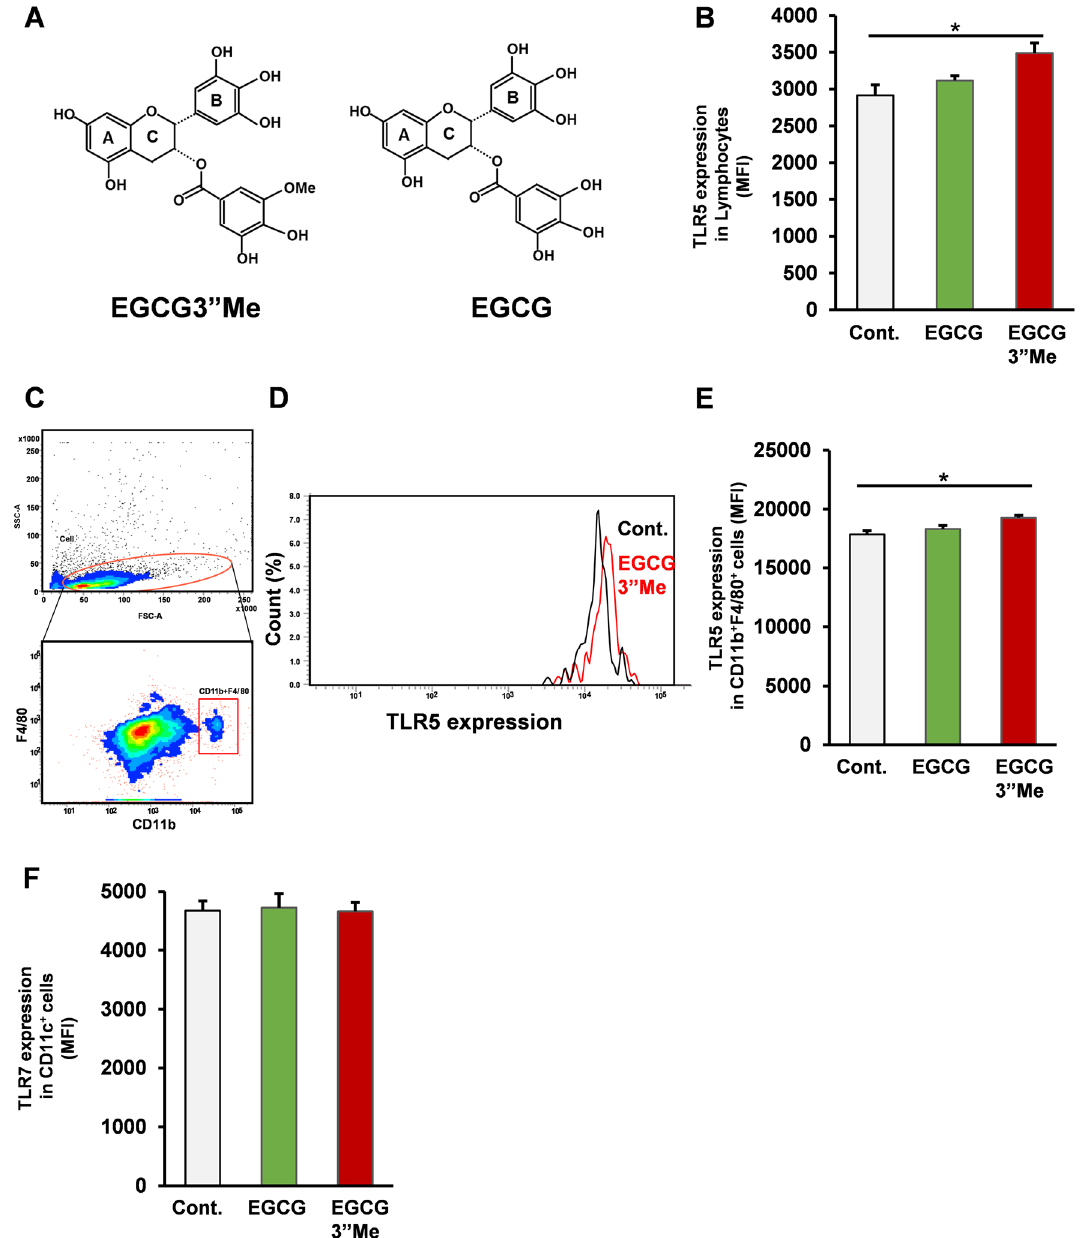
Figure 1. EGCG3”Me intake upregulated TLR5 expression in vivo. ( A ) The chemical structure of EGCG3”Me ( B – E ) 12-week-old female BALB/c mice were orally administrated with vehicle, EGCG (10 mg/kg intragastric administration), or EGCG3”Me (10 mg/kg intragastric administration) every day. After 1 week, mice were sacrifced and TLR5 expression was determined by flow cytometry ( B ) TLR5 expression in lymphocytes, ( C – E ) TLR5 expression in CD11b + F4/80 + cells. (n = 8). ( F ) TLR7 expression was evaluated by flow cytometry (n = 8). Data are presented as means ± SEM * P <